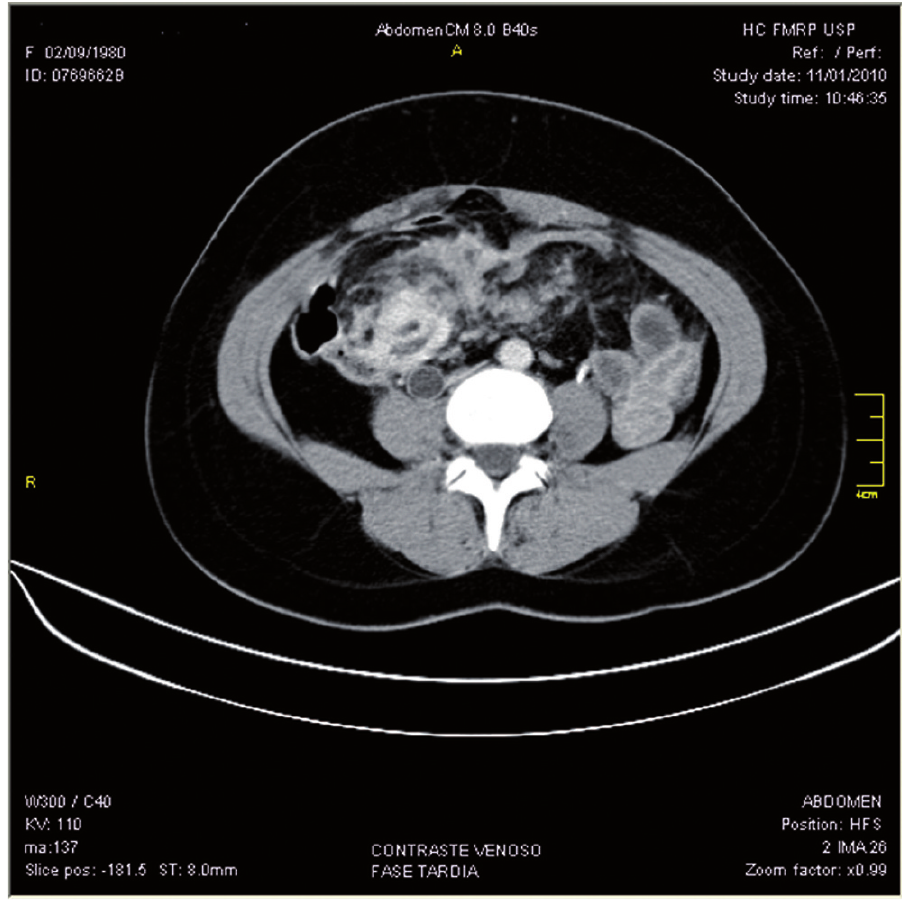
Figure 1 - Computed tomography showing a huge mass in